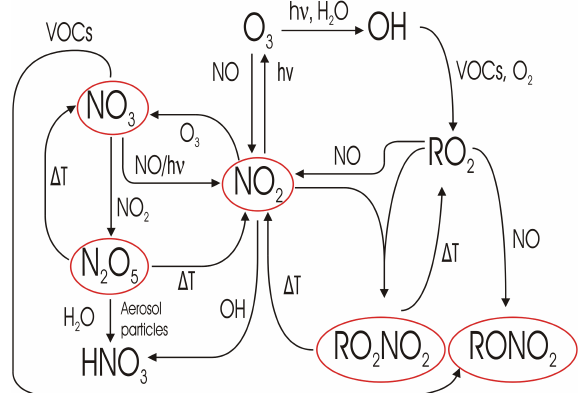
Figure 1. Atmospheric sources and sinks of the NO y species (in red circles) measured by the five-channel TD-CRDS instrument de- scribed in this work and their link to VOC degradation and photo- chemical O 3